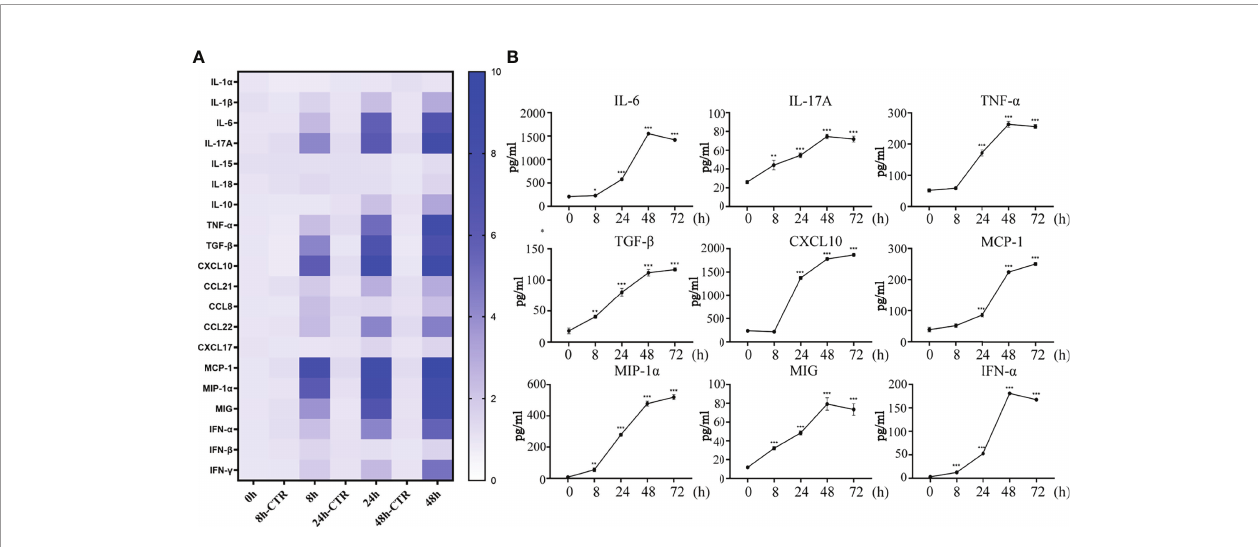
FIGURE 2 | H1N1 virus promotes secretion of cytokines, chemokines and interferons in hNEC cells. (A) hNECs were infected with 0.1MOI titer virus for 8 hours, 24 hours, and 48 hours later, the cellular mRNA was extracted, and the expressions of different cytokines, chemokines and interferons were detected at the mRNA level. The histogram of the gradient on the right shows the different folds of change (0~10). (B) Cytokines, chemokines and interferons with obvious changes were screened out, and their secretion levels in the culture supernatant were detected by ELISA. Statistical signi fi cance is shown using the Student ’ s t test analysis, *P < 0.05; **P < 0.01; ***P <